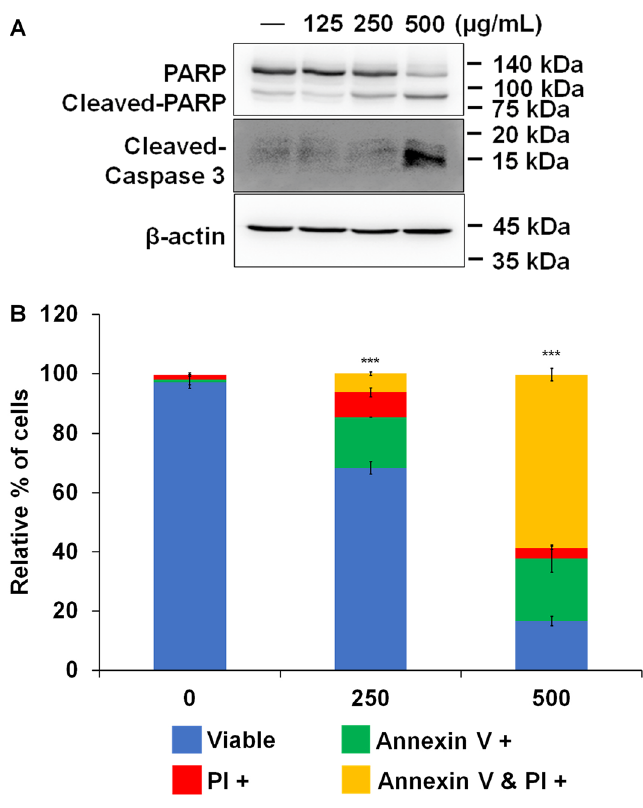
Figure 2. AOFE induces apoptosis in head and neck cancer cells. ( A ) FaDu cells were treated with various concentration of AOFE for 24 h. Western blot analysis was used to analyze protein expression of apoptosis- related factors. ( B ) FaDu cells were treated with indicated concentration of AOFE for 24 h. Apoptotic cell death was analyzed by Arthur image based cytometry after staining with annexin V and PI. The data are shown as the mean ± SD. The Y-axis represents the percent of cells positive for annexin V (green), PI (red), annexin V and PI (yellow), or negative for annexin V and PI (blue). *** p < 0.001 vs. control (comparison of viable